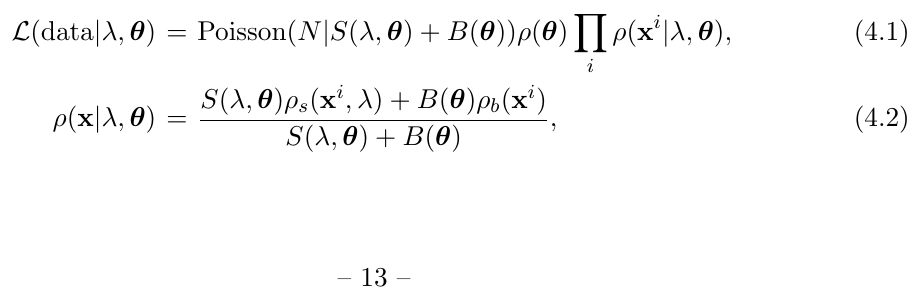
Figure 12 . Angular coe(cid:14)cients and the y Z nario S2 a